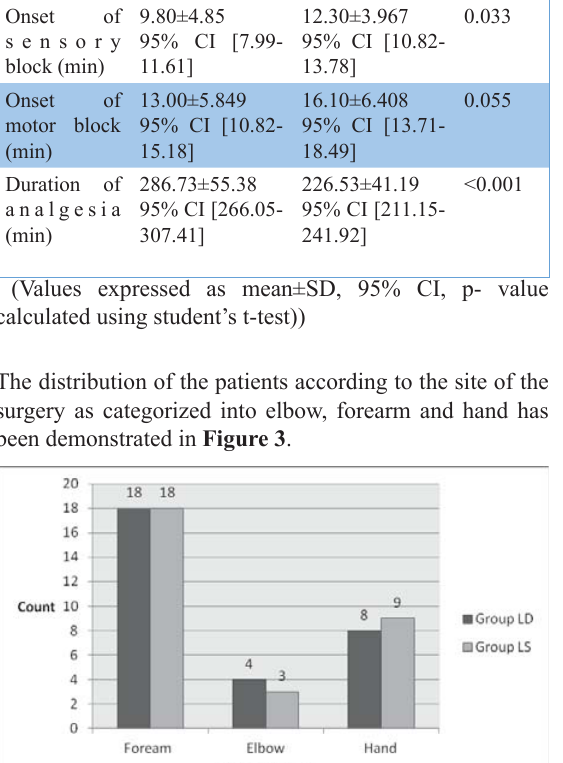
The baseline hemodynamic parameters of the study